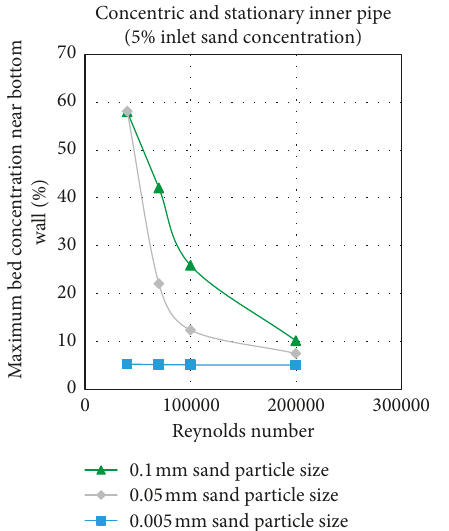
Figure 16: Effect of sand particle size on bed concentration near wall. bottom wall is almost constant at different flow rates. That means, for smaller particle size ( < 0.01 mm), the effect of the flow rate on particle deposition in negligible.